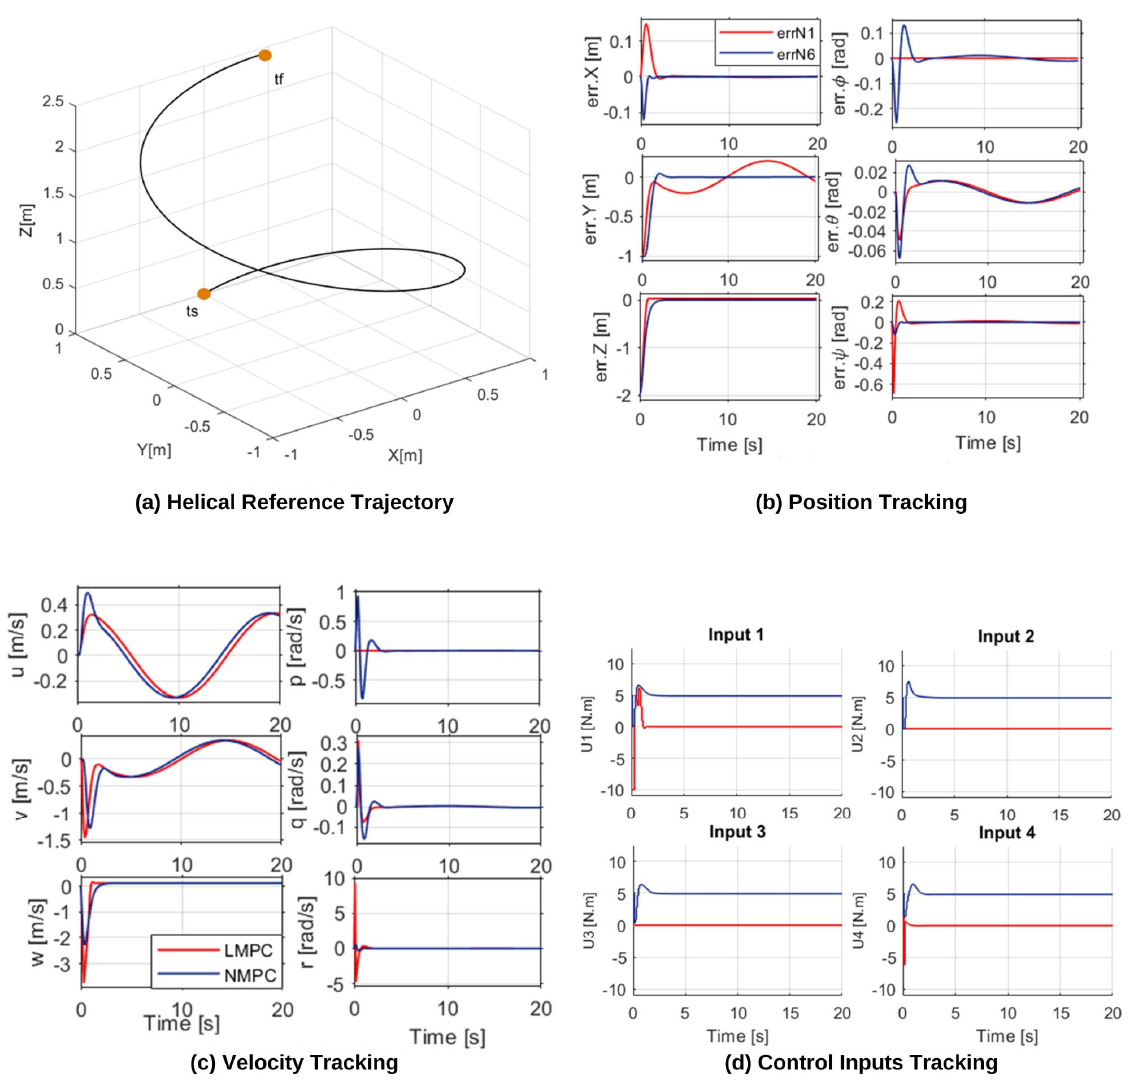
Figure 11. Circular reference trajectory.